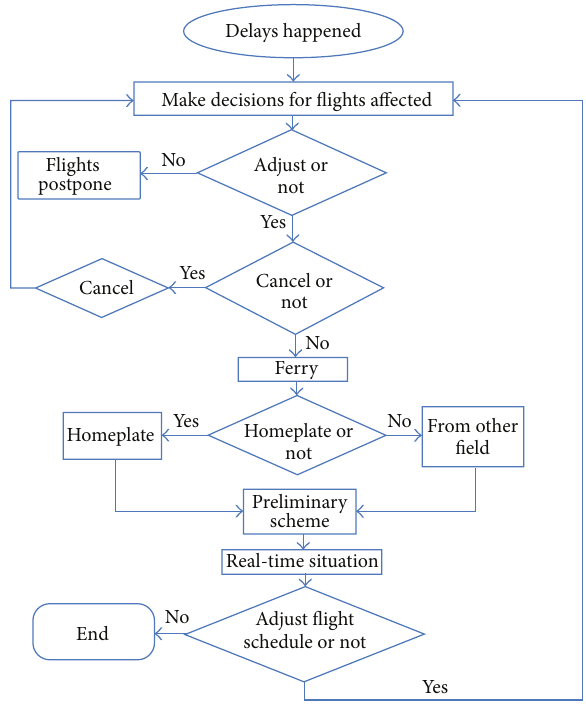
Figure 1: Flow chart of